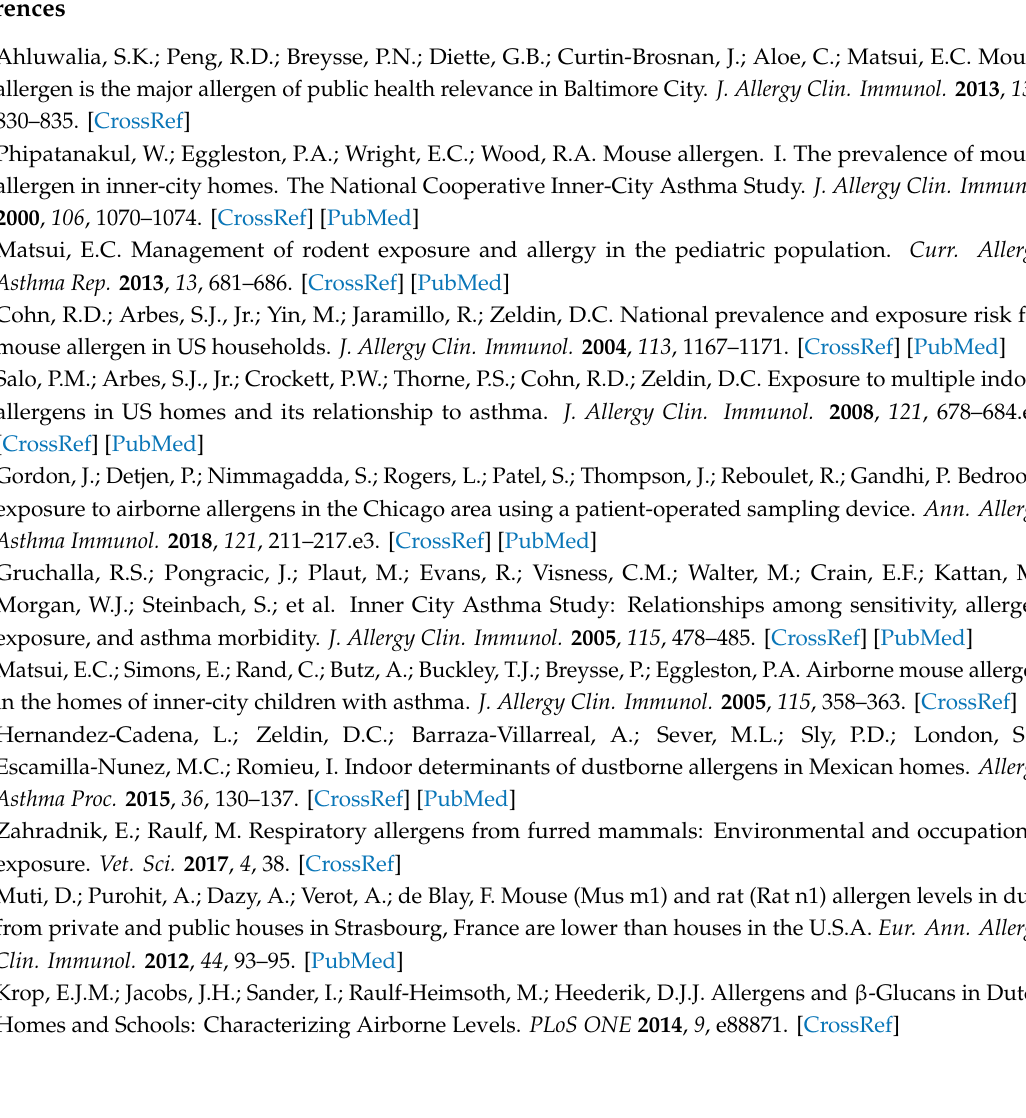
Figure S1: Map of the Netherlands showing the geographical distribution of homes sampled in this study (n = 80). File S1: